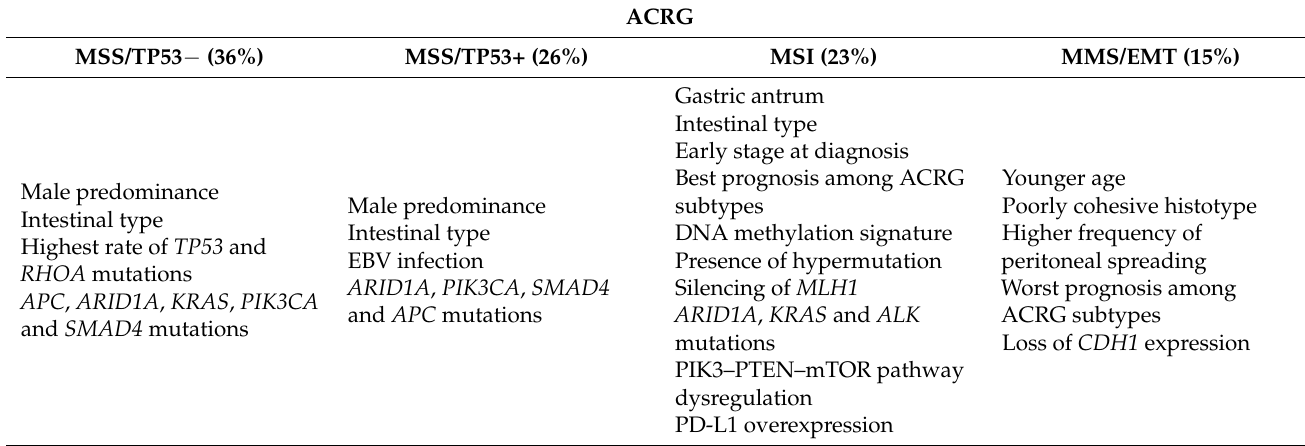
Table 2. Principal molecular and clinicopathological features of ACRG molecular subtypes.